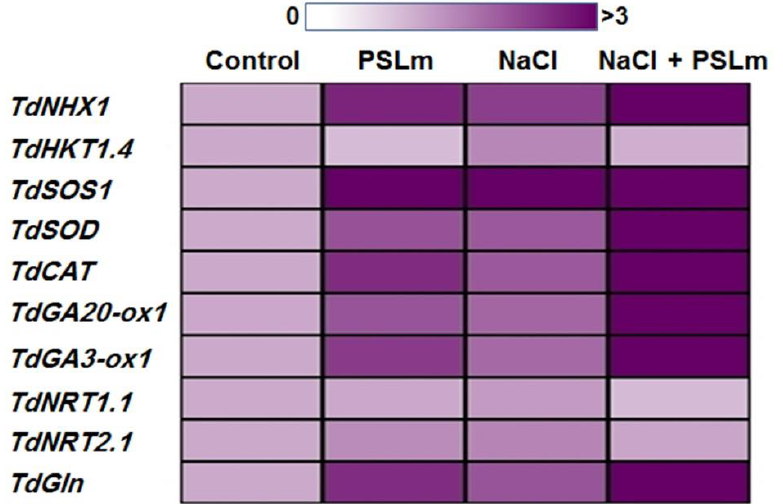
Figure 5. Heatmap depicting the expression pattern of ten stress-related genes ( NHX1 , HKT1.4 , SOS1 , SOD , CAT , GA20-ox1 , GA3-ox1 , NRT1.1 , NRT2.1 , and GS ) under control and salt-stressed (150 mM NaCl) durum wheat seedlings cultured in 1/2 MS medium supplemented with (2 mg/mL) or without PSLm extract for 20 days. The data represent means of three independent experiments. Color code is presented above the